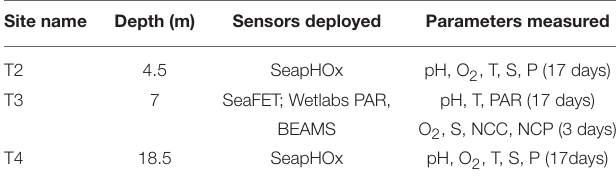
TABLE 1 | Summary of sensor deployments for this